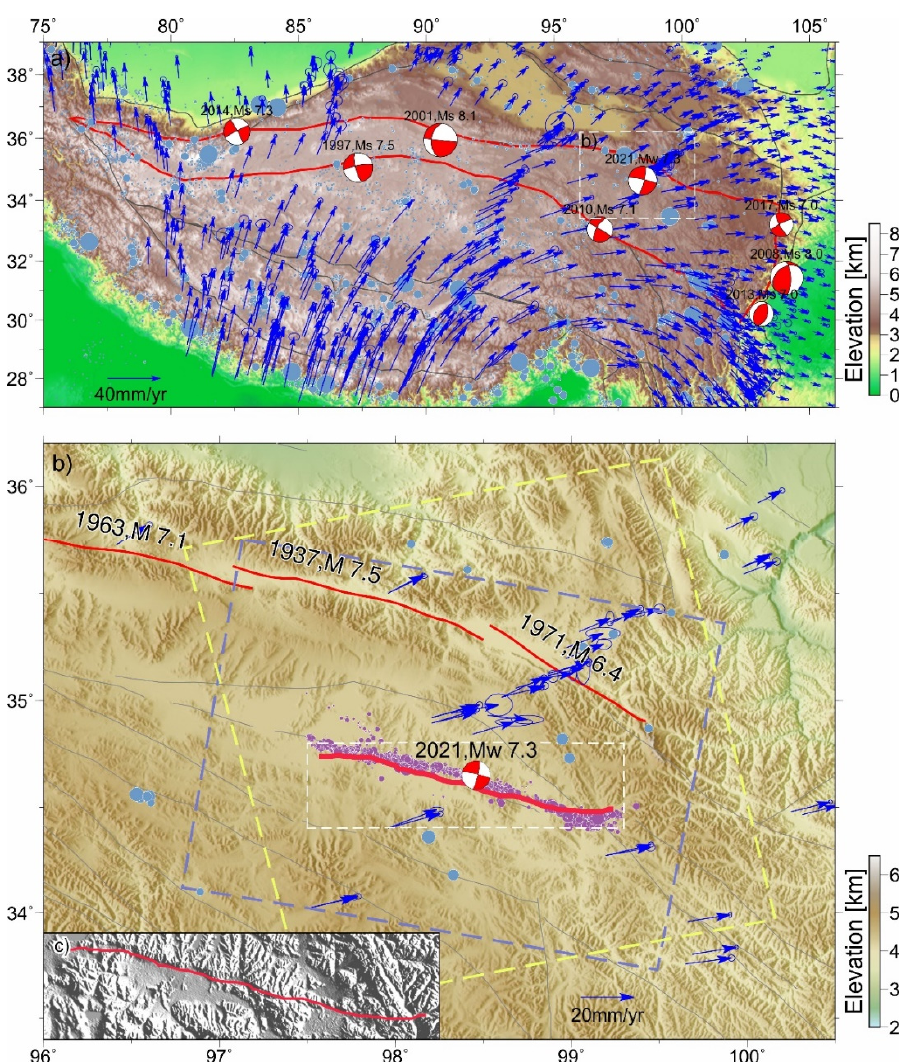
Figure 1. Tectonic setting of the 2021 Mw 7.3 Maduo earthquake. ( a ) Tectonic setting of the Bayanhar block. Blue arrows show GPS measured interseismic velocities with ellipses indicating uncertainties [18,19]. The red line indicates the boundary of the Bayanhar block. Light blue dots indicate M > 2 earthquakes (1 January 1900–20 May 2021, https://earthquake.usgs.gov/earthquakes/search/, accessed on 21 May 2021). ( b ) Enlarged tectonic map around the Maduo area. Blue arrows is same as in ( a ). Light purple circles indicate the relocated aftershocks (22 May 2021–28 May 2021) [20]. Light blue dots indicate M > 3 historical earthquakes (1 January 2011–20 May 2021, http://www.ceic.ac.cn/history, accessed on 21 May 2021). Thick red line indicates the surface rup- tures of the Maduo earthquake. Thin red lines denote the rough extent of the historical ruptures on the Kunlun fault. Light yellow and light blue dashed boxes mark the spatial coverage of ascending and descending Sentinel-1 SAR images, respectively. The white dashed line illustrates the range of ( c ). ( c ) Digital elevation model (https://earthexplorer.usgs.gov/, accessed on 21 May 2021) around the Maduo earthquake. Red lines demonstrate the surface ruptures of the Maduo earthquake.